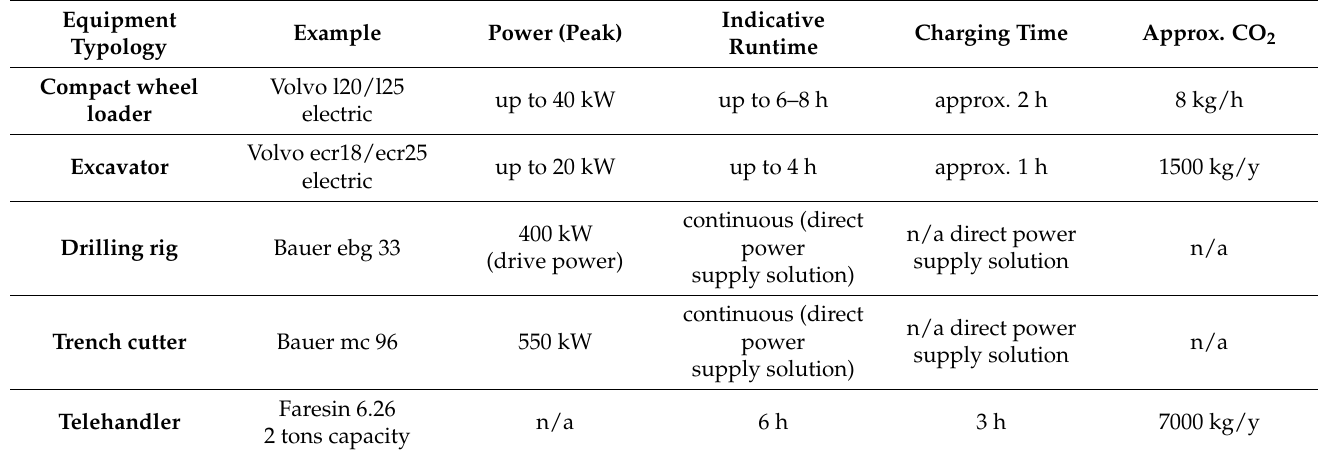
Table 2. Construction machinery key data for fuel-free